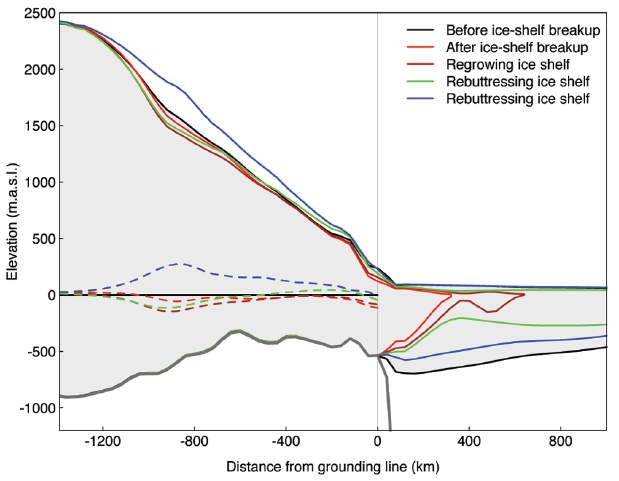
Fig. 2. Simulated along-flow profiles of surface elevation. Colors indicate different phases of the Hudson-Bay/Strait ice stream with respect to the Labrador ice shelf status and go from black (initial un- perturbed steady state) to red (after 500yr of enhanced basal melt- ing), brown (1100yr after the onset of the perturbation; 100yr after the end of the enhanced basal melting period), green (1900yr after the onset of the perturbation; 900yr after the end of the enhanced basal melting period) and blue (3000yr after the onset of the pertur- bation; 2000yr after the end of the enhanced basal melting period). Dashed lines show the elevation anomaly relative to the steady state.